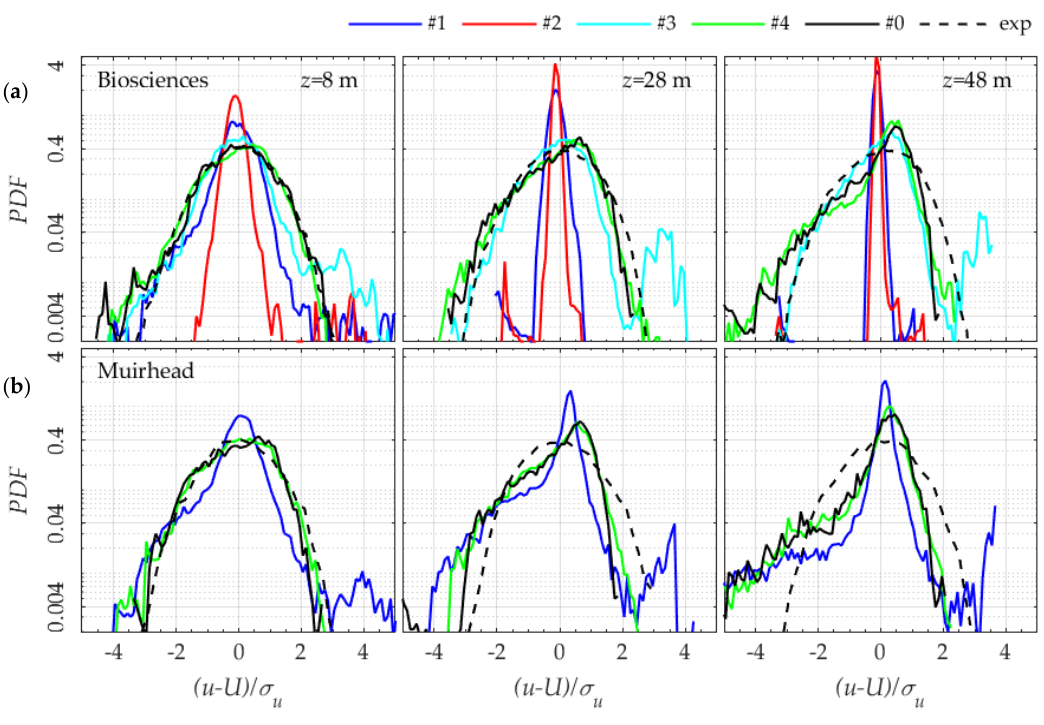
Figure 15. Probability Density Function of the horizontal velocity at several heights above the Muirhead tower ( a ) and Biosciences tower ( b ).